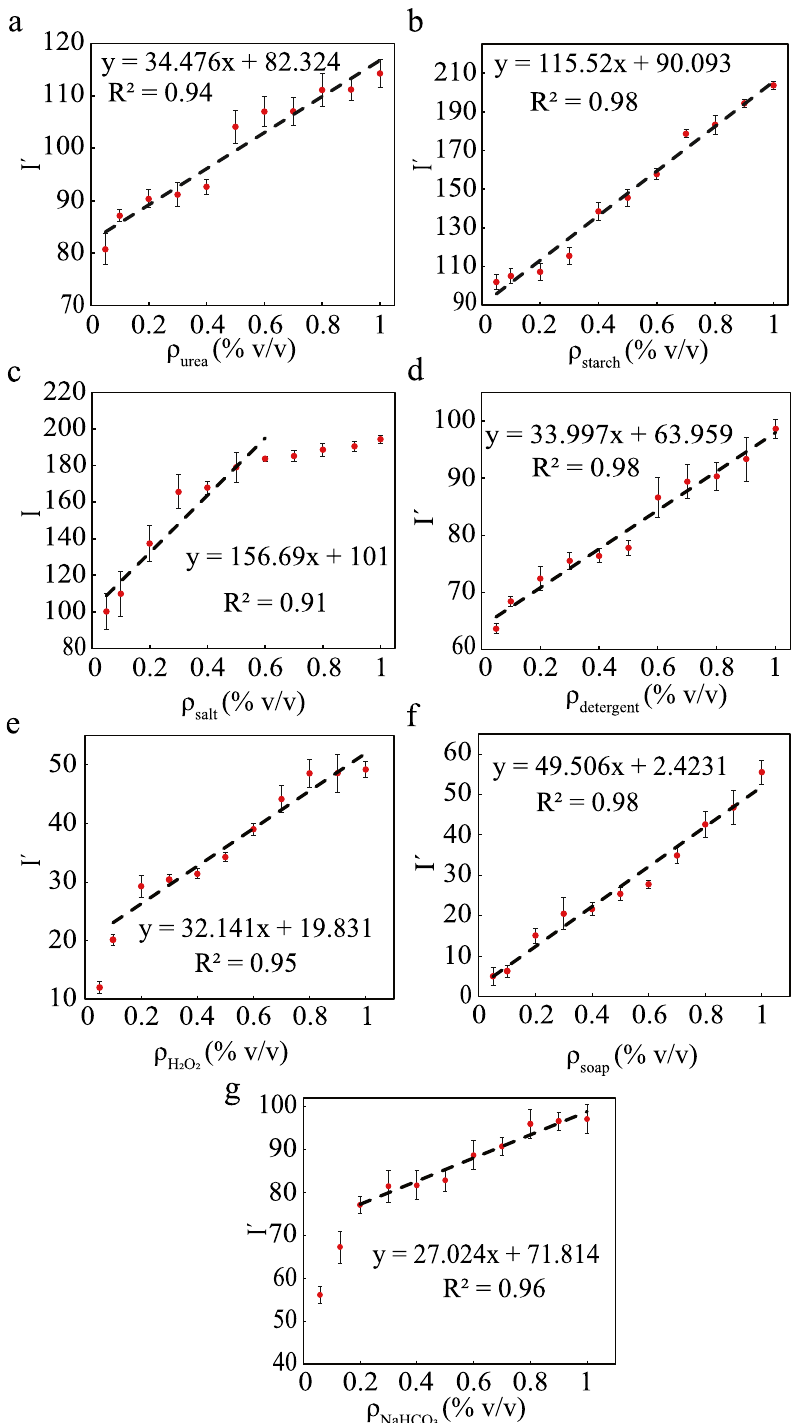
Figure 2. Color intensity curves are shown for eight different adulterants with varying concentration from 0.05% to 1% (v/v) added in milk for ( a ) urea, ( b ) starch, ( c ) salt, ( d ) detergent, ( e ) hydrogen peroxide, ( f ) soap, and ( g ) sodium-hydrogen-carbonate. From the figure it is clear that with increasing concentration the color intensity is also